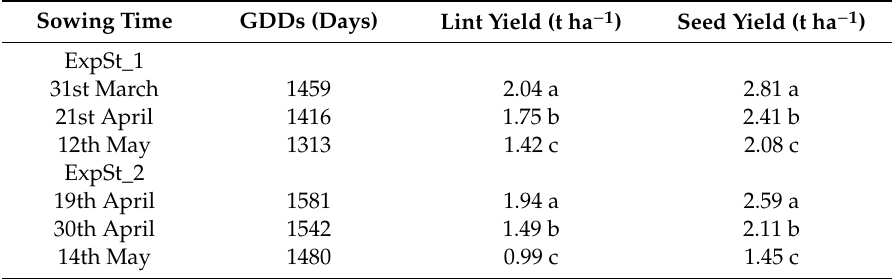
Table 7. Relationship between GDDs and cotton